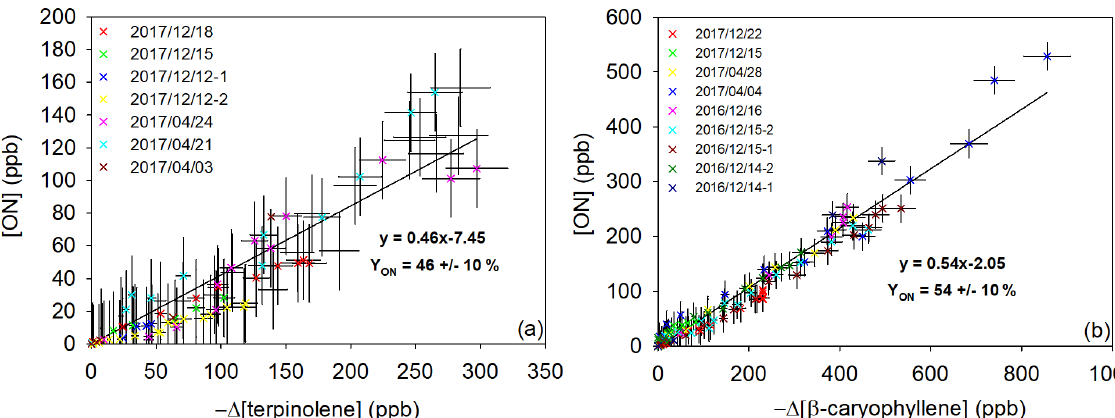
Figure 6. Gas-phase organic nitrate production vs. loss of terpinolene (a) and of β -caryophyllene (b) .